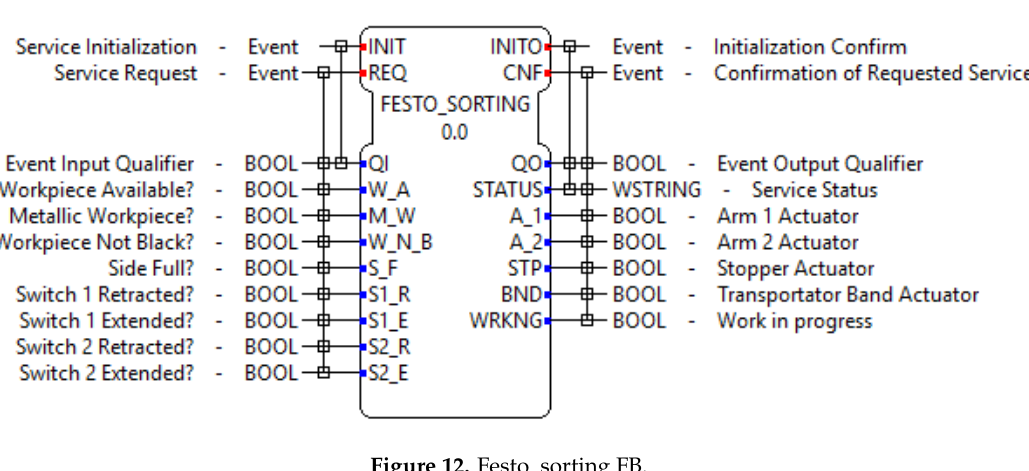
Figure 12. Festo_sorting